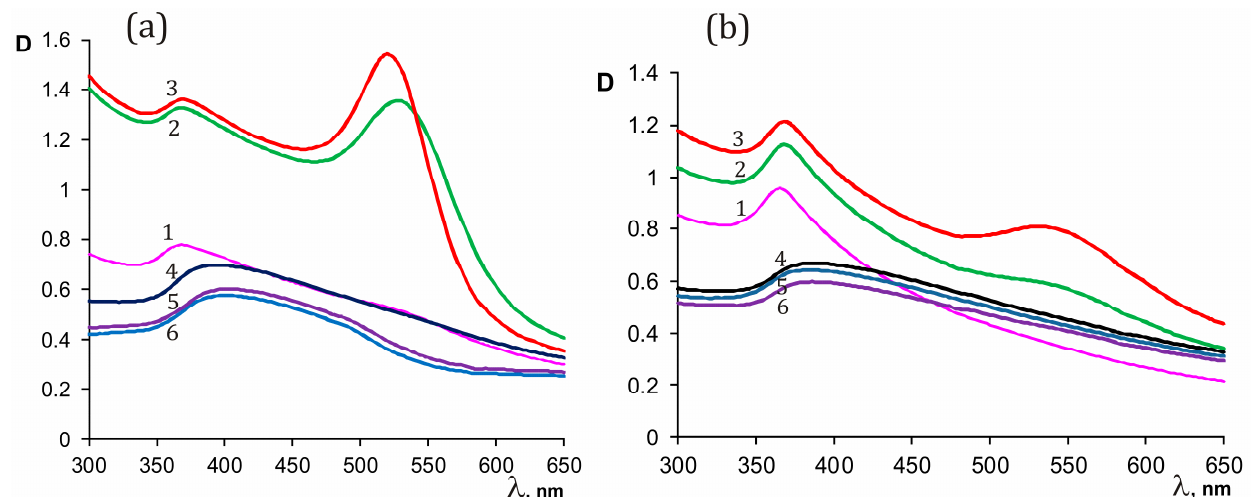
Figure 2. UV-Vis spectra of systems VM/Au 3+ /Zn 2+ ( a ) and SM/Au 3+ /Zn 2+ ( b ) under molar ratio of copolymer maleic acid residues/gold cations/zinc cations 1/0.15/0.23 (1–2 min, 2–1 h, 3–4 h) and VM/Zn 2+ ( a ) and SM/Zn 2+ ( b ) under molar ratio of copolymer maleic acid residues/zinc cations 1/0.23 (4–2 min, 5–1 h, 6–4 h); 95 °C, initial pH 12.